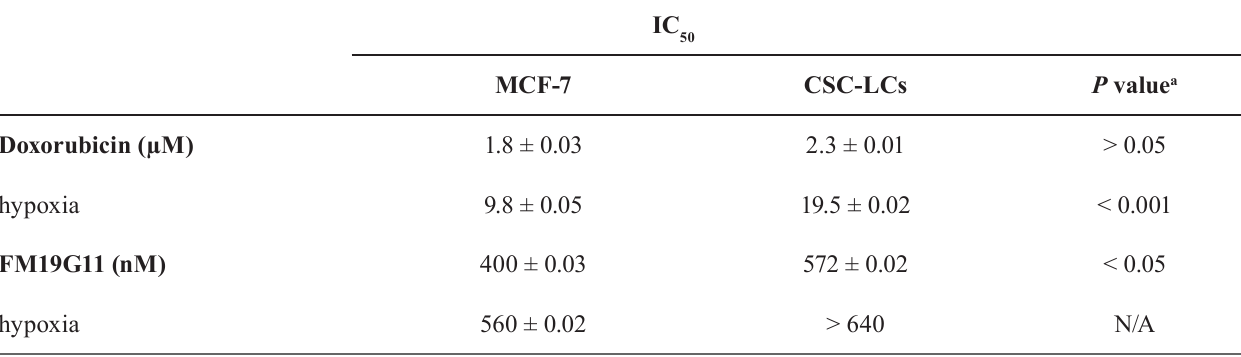
TABLE I - C ytotoxicity of the doxorubicin and FM19G11 against MCF-7 and